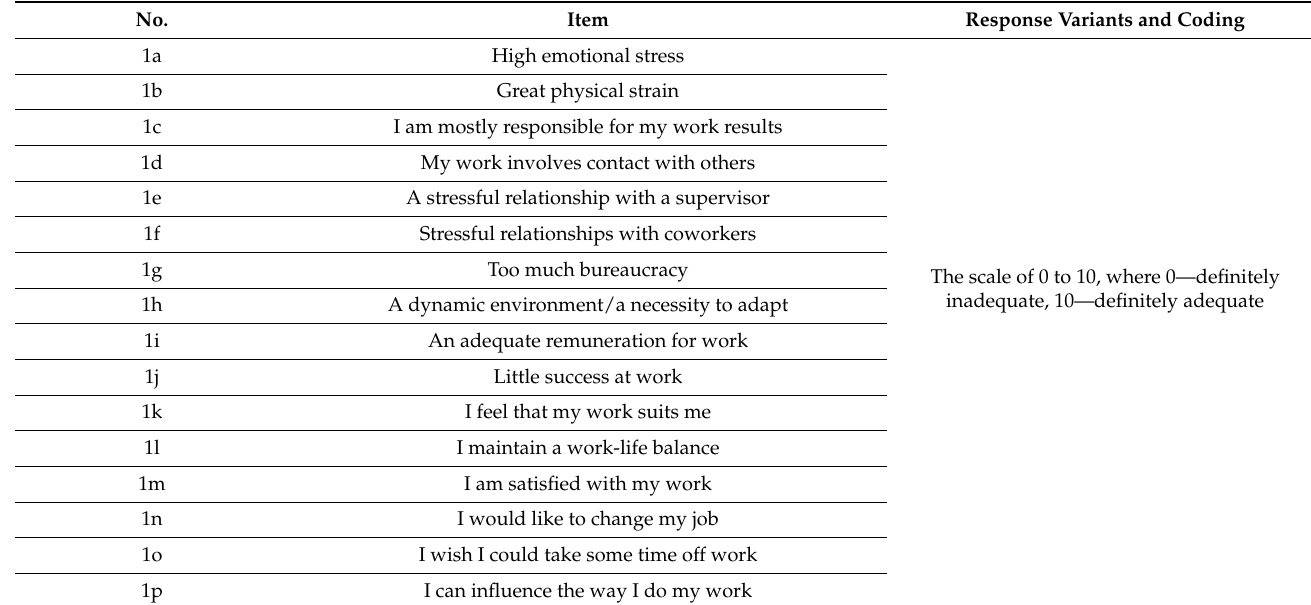
Table A1. General questions about work: Please assess to what extent each of the questions describes your current job. No. Item Response Variants and